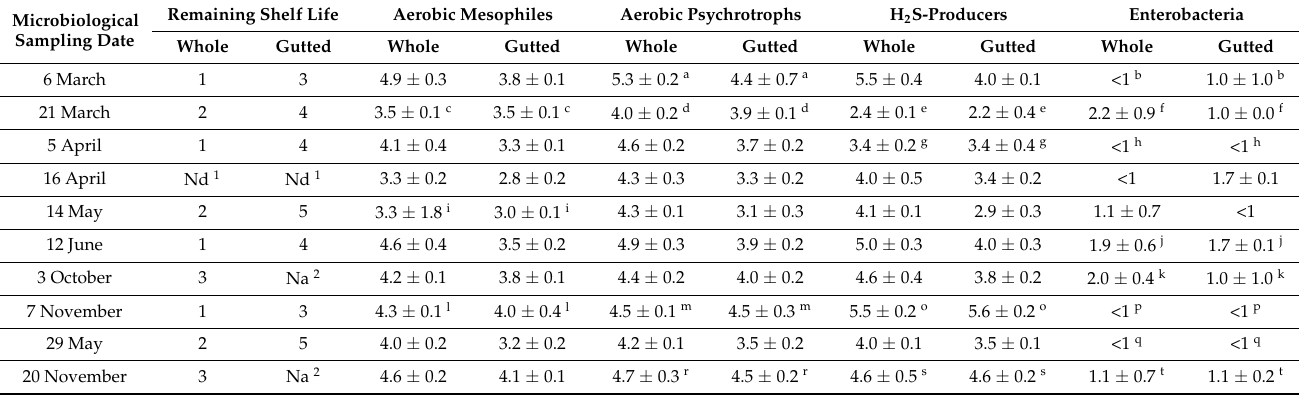
Table 2. Aerobic mesophilic bacteria, aerobic psychrotrophic bacteria, H 2 S-producing bacteria, and enterobacteria counts in whole and gutted herring fished at different seasons are presented as log 10 CFU g − 1 . The remaining shelf life of the fish batches is shown in